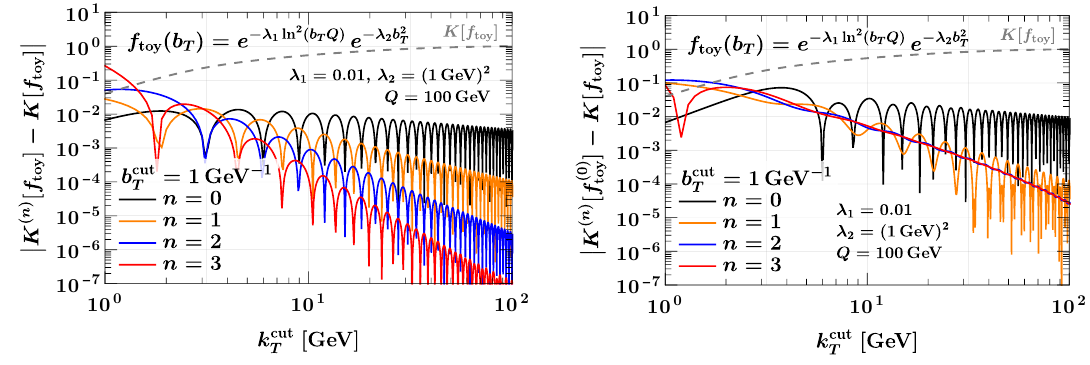
Figure 3 . Same as figure 2, but for the cumulative functionals K ( n ) [ f ]( k cut